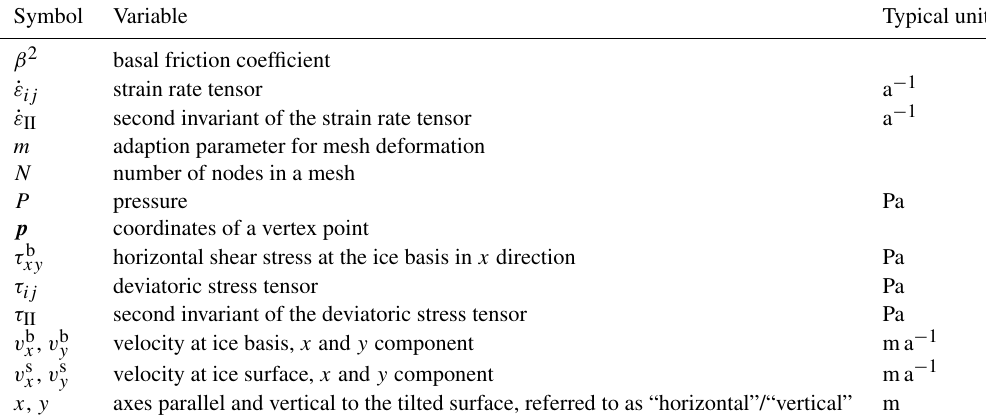
Table 2. Symbols used in this paper and not listed in Table 1. Symbol Variable Typical